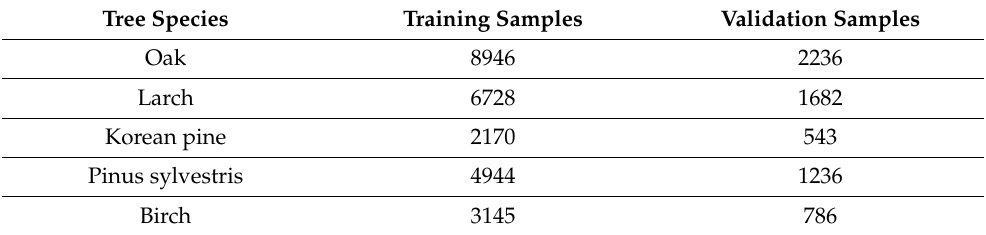
Table 2. Number of sampling points for each tree